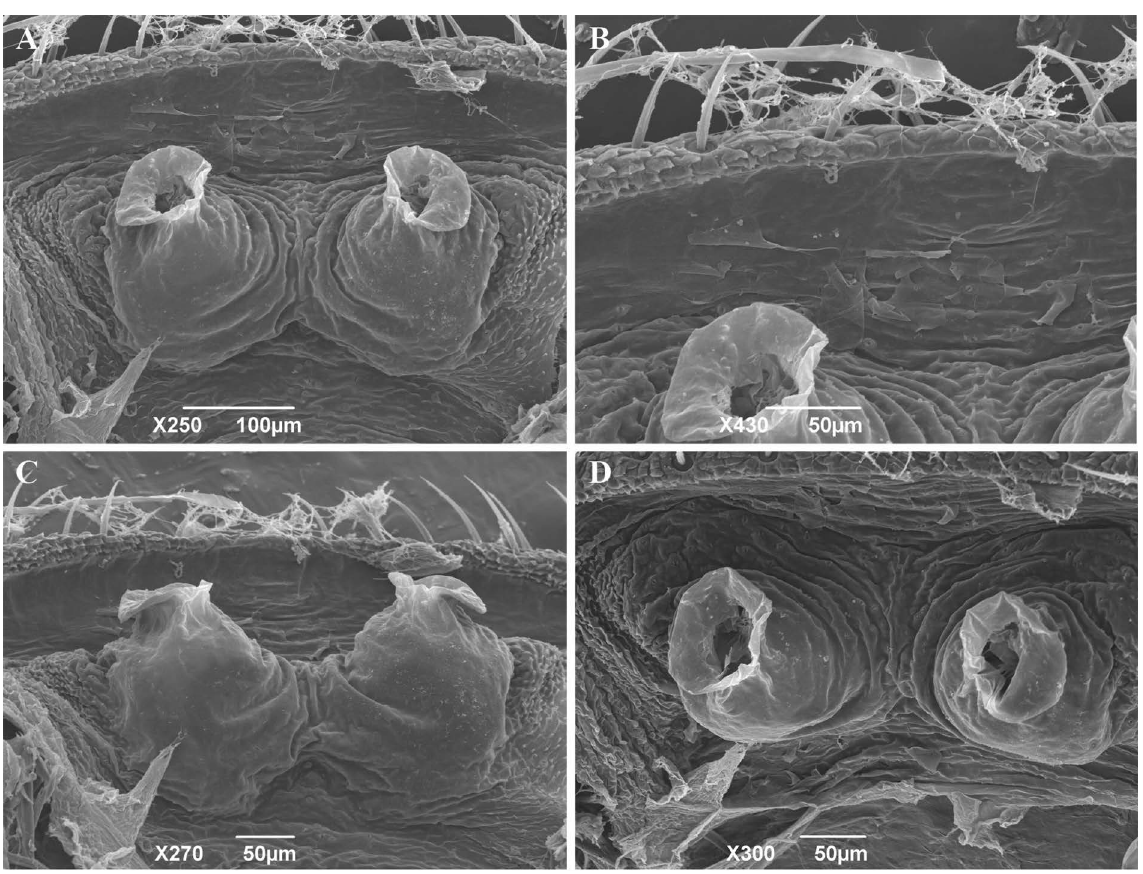
Fig. 65. Charinus goitaca sp. nov. (MNRJ 9360), female gonopod and genital operculum. A . Sucker- like gonopod, dorsal view. B . Genital operculum between gonopods. C . Gonopods, anterior view. D . Gonopods